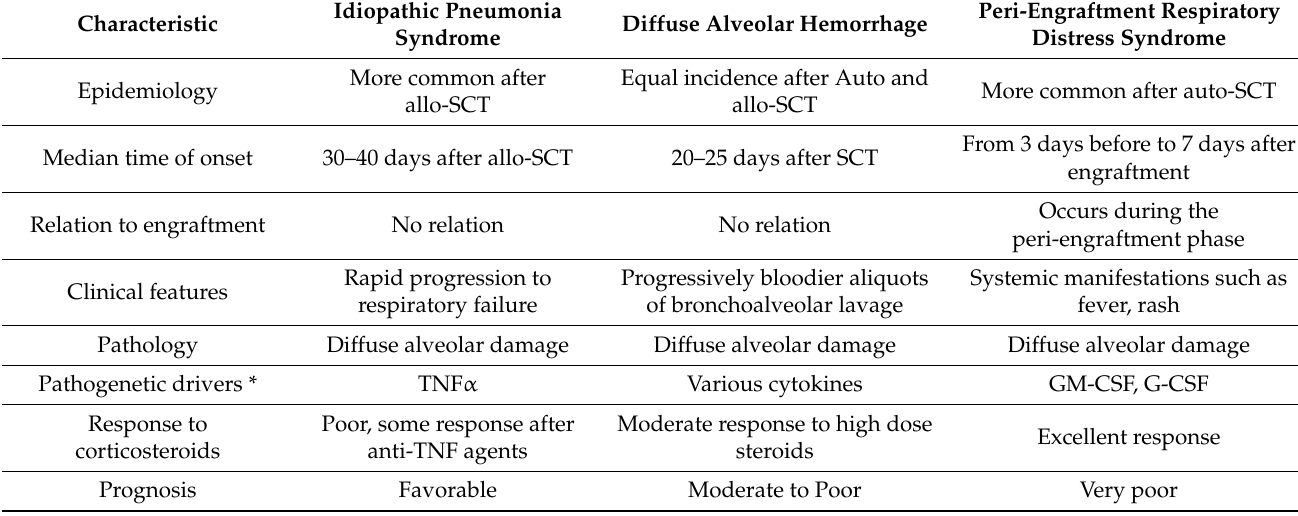
Table 2. Clinical features of acute lung injury syndromes post stem cell